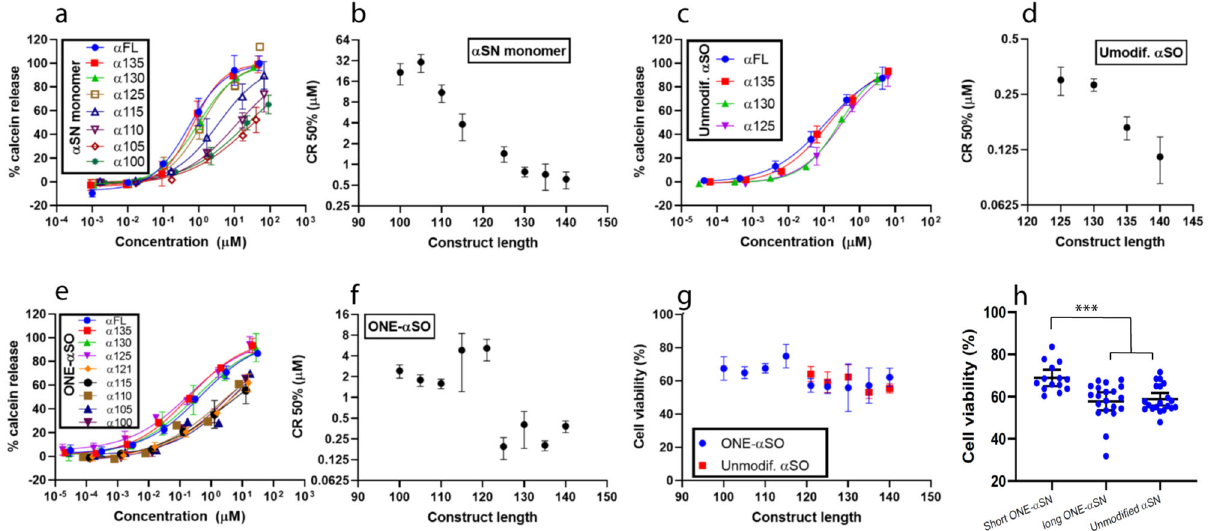
Fig. 4 Vesicle permeabilization and cell toxicity properties of CTD truncated α SN and their oligomers. a – f Vesicle permeabilization by truncated α SN constructs. Permeabilization assays with truncated α SN monomers ( a , b ), unmodi fi ed α SOs ( c , d ), and ONE-modi fi ed α SN monomers ( e , f ) shows more aggressive behavior for oligomers in comparison to monomers, however, ONE- α SO121 and the shorter ones are not as aggressive as the ONE- α SO125 and longer oligomers. g , h Cell viability with 10 µ M oligomer con fi rms the results of vesicle permeabilization. In h α SOs of α SN121 and longer variants are binned into one group and α SN115 and shorter variants into another. Cell toxicity of each group was compared by ANOVA (in graph pad software). *** p - value ≤ 0.001. Each point is the average of three repeats for permeabilization or four repeats for cell toxicity where error bars show standard deviation. Error bars for h show 95%